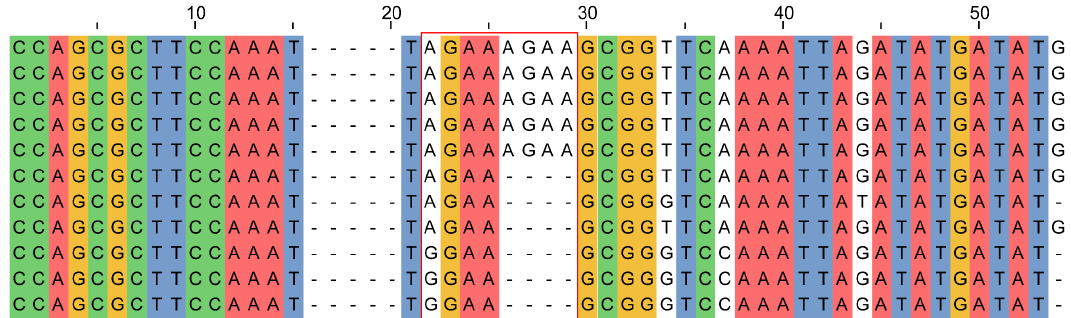
Figure 1. Phylogenetic tree constructed based on 179 ITS sequences of Nymphaea . Bootstrap values (> 50) and posterior probabilities (> 0.5) based on the NJ and BI analyses are shown above the branches. The rough branches mean identified species by ITS tree.